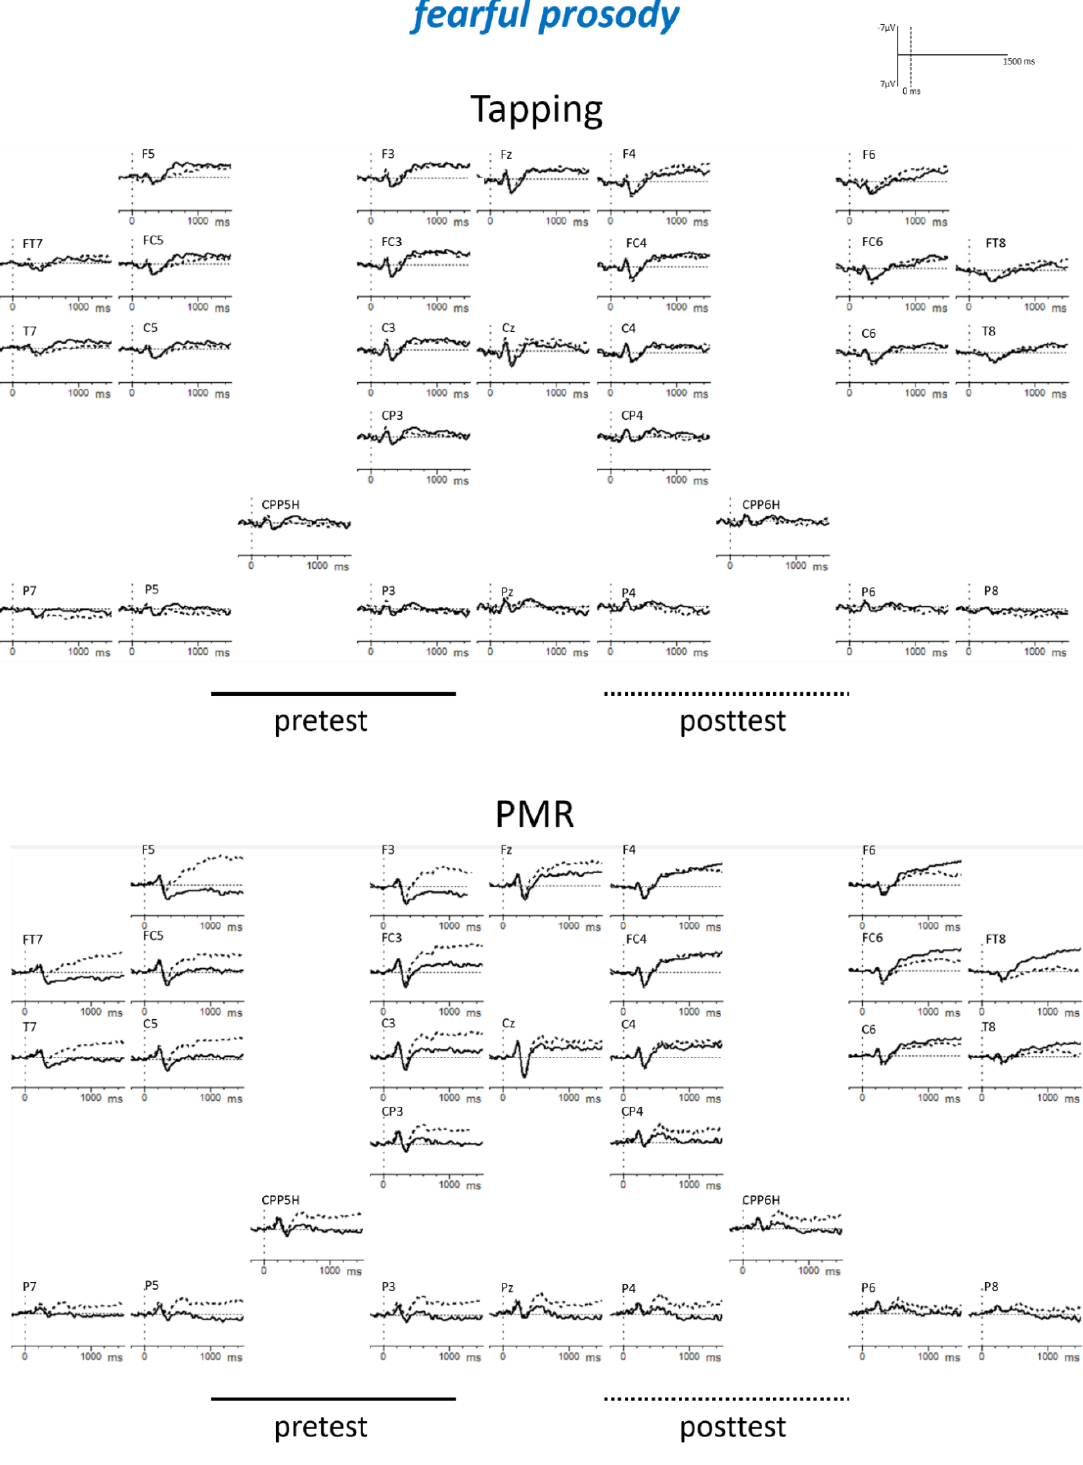
Figure A4. EEG results for all electrodes when processing fearful prosody. Positive polarity is plotted downwards.